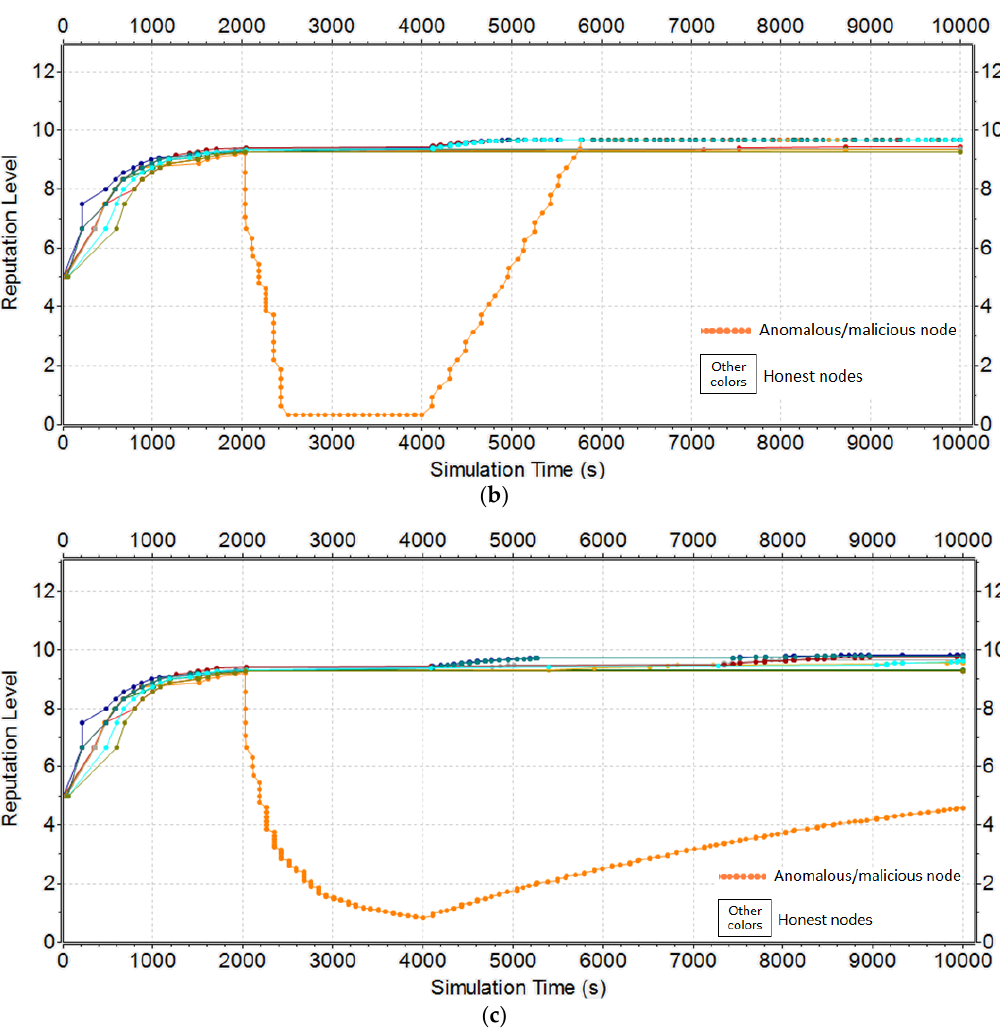
Figure 17. ( a ) Simple Summation mechanism, ( b ) Bayesian inference mechanism with longevity factor, and ( c ) Bayesian inference mechanism without longevity factor.